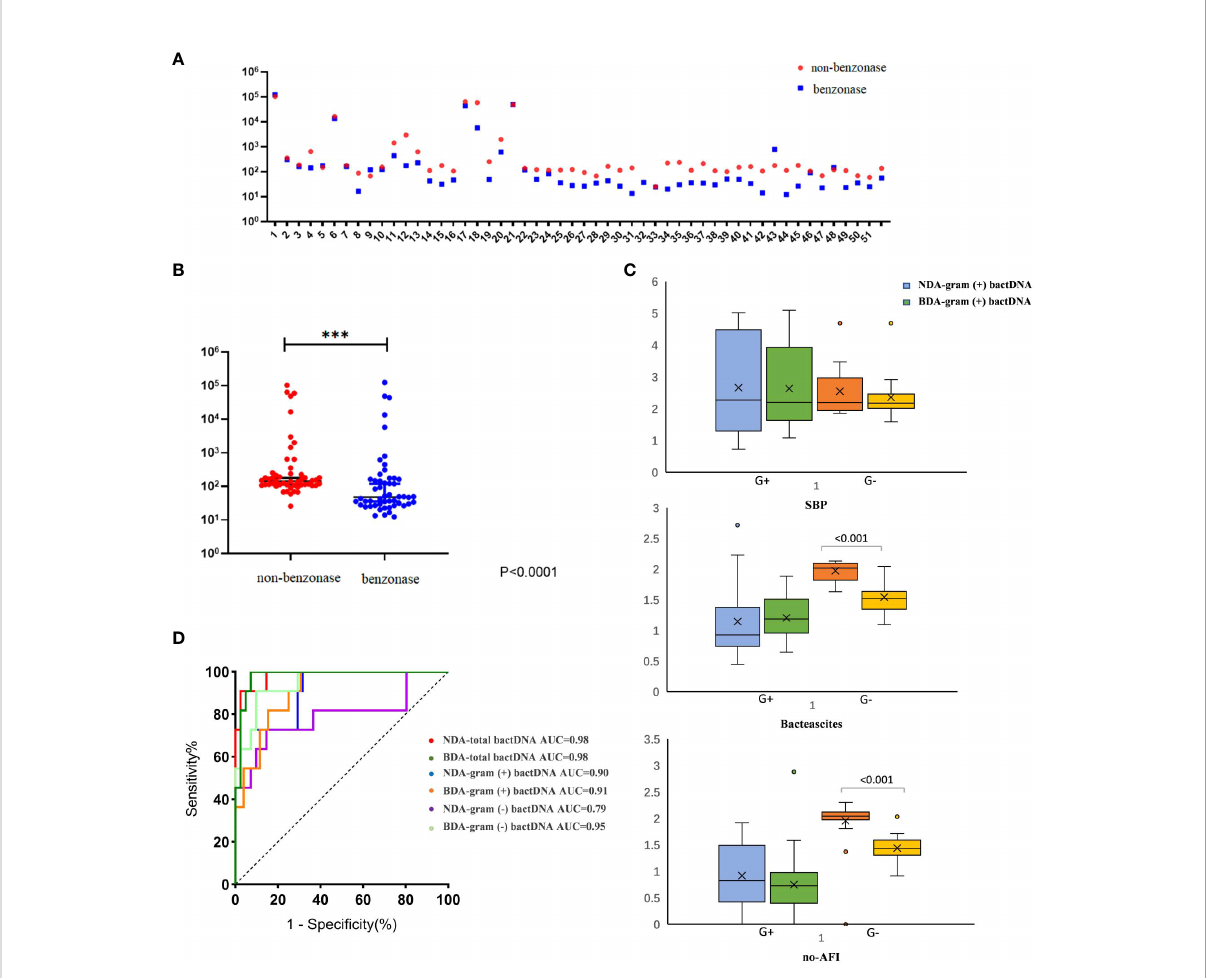
FIGURE 3 Clinical evaluation of an improved ddPCR quantitation method. (A) Fifty-four patients were selected in this comparison [SBP, 13; no-SBP, 41 (bacterascites, 15; no-AFI samples, 26)]. (B) Comparison between the non-dependent assay (NDA) and benzonase-dependent assay (BDA). (C) The results of Gram-positive and Gram-negative bactDNA quantitation of NDA and BDA in patients with SBP, bacteascites, and no-AFI. (D) ROC curves strati fi ed by two different methods of NDA and BDA (n = 54 samples in total) based on clinical composite standards. NDA, non- dependent assay; BDA, benzonase-dependent assay; SBP, spontaneous bacterial peritonitis; AFI, ascites fl uid infection; ***P <